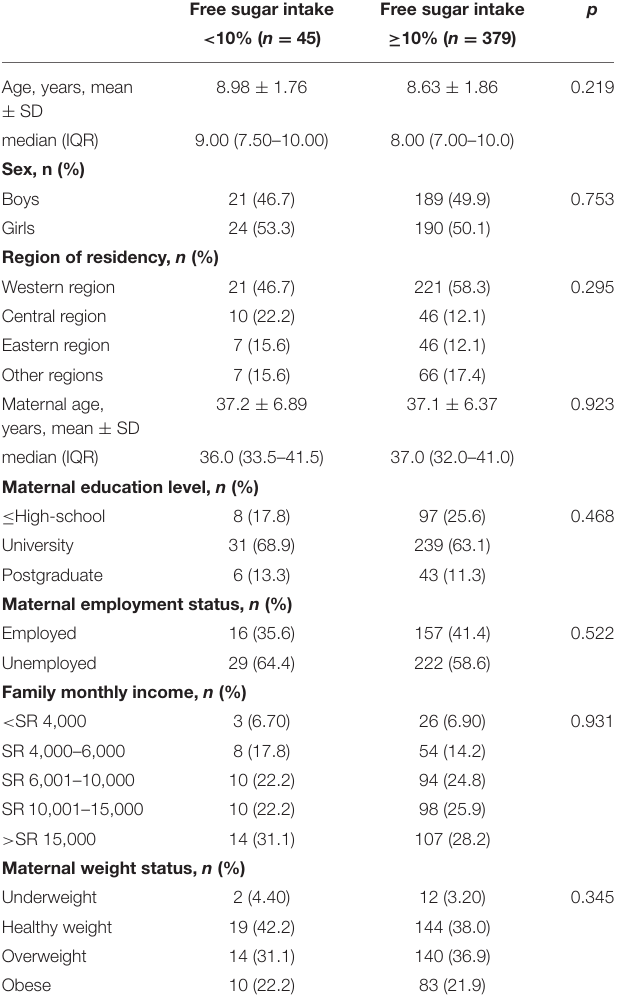
TABLE 1 | Characteristics of children stratified by percent of free sugar